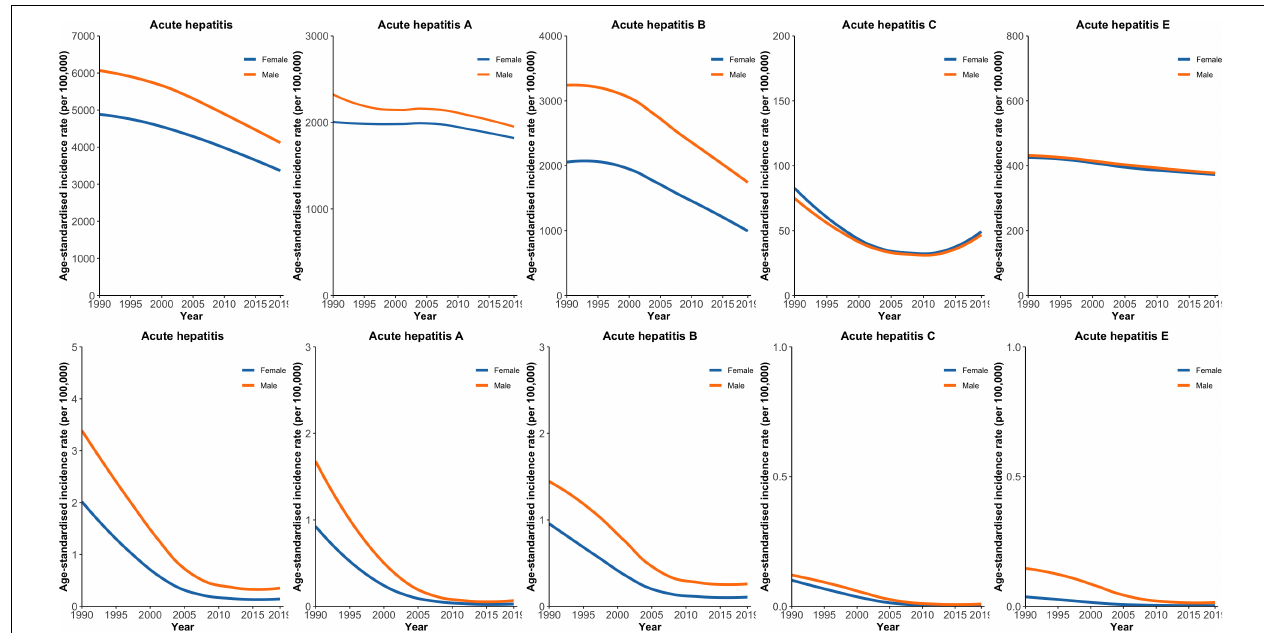
FIGURE 1 | Temporal trends in age-standardized incidence rate (ASIR) and age-standardized mortality rate (ASMR) for total acute viral hepatitis and its type by gender.